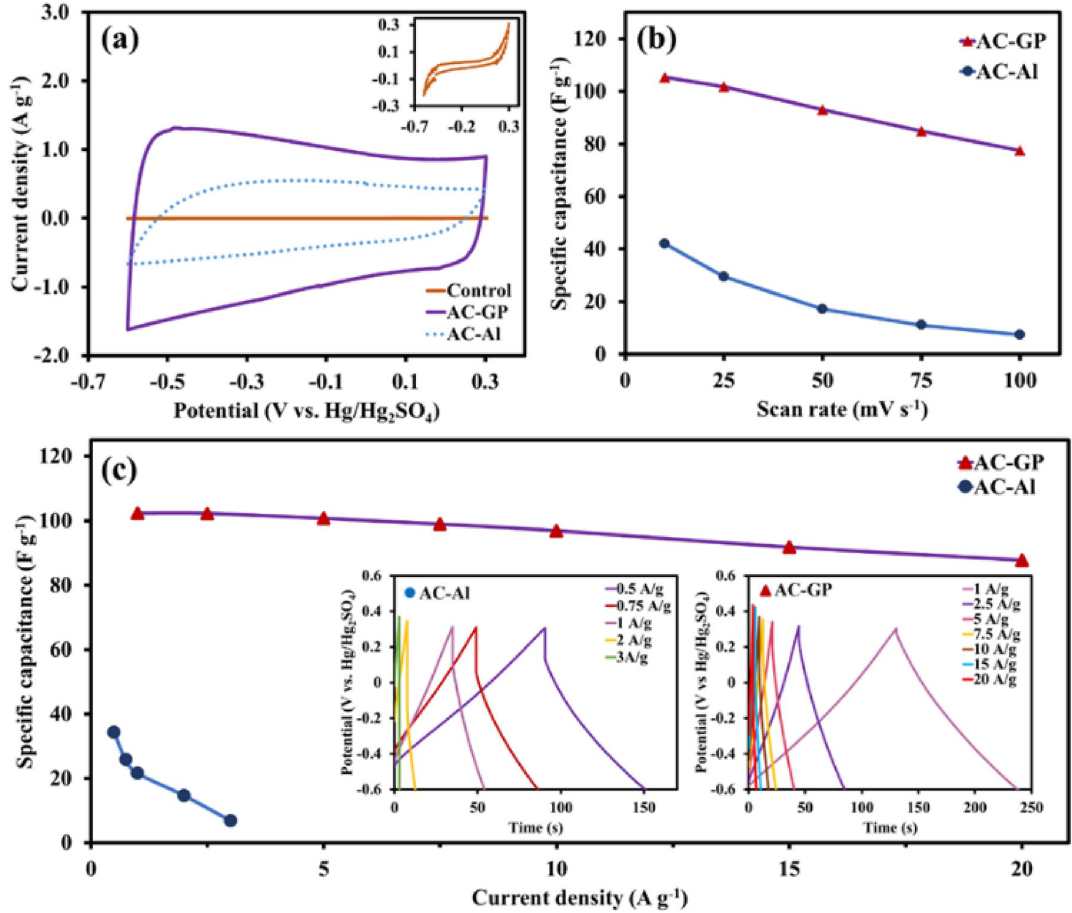
Figure 2. ( a ) CVs at 10 mV s −1 (inset: CV profile of a control); and ( b ) specific capacitances at different scan rates; and ( c ) specific capacitances as a function of current densities (inset: GCD profiles at various current